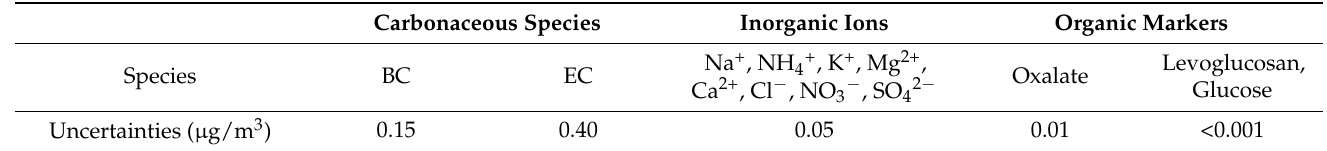
Table 1. Input variables and uncertainties used in the EPA PMF 5.0